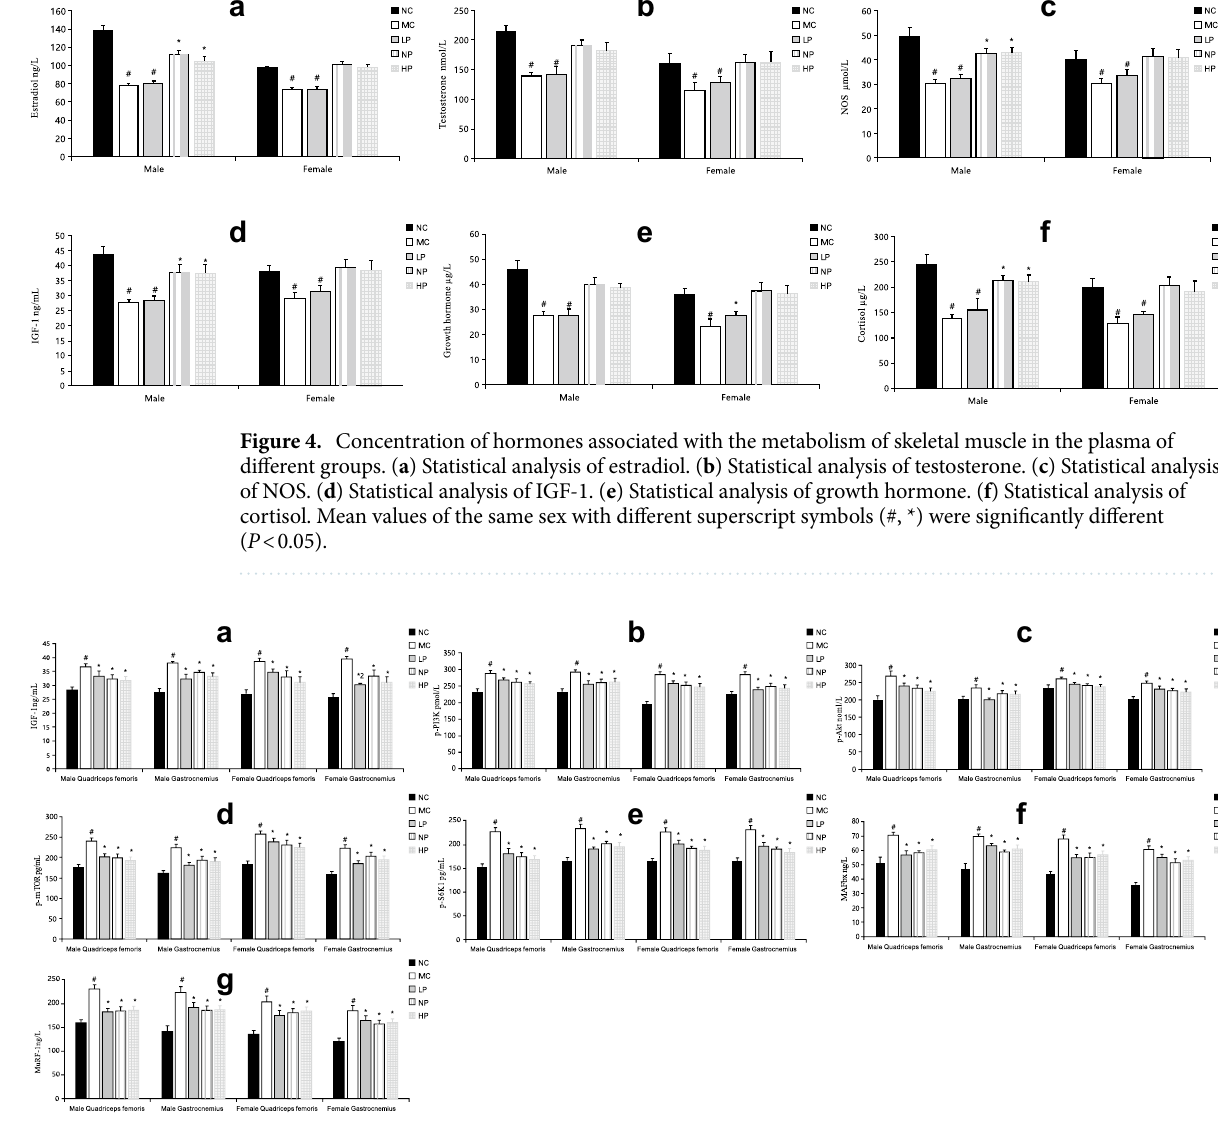
Figure 5. Concentration of factors in the pathways associated with the protein metabolism in the skeletal muscles of different groups. ( a ) Statistical analysis of IGF-1. ( b ) Statistical analysis of p-PI3K. ( c ) Statistical analysis of p-Akt. ( d ) Statistical analysis of p-mTOR. ( e ) Statistical analysis of p-S6K1. ( f ) Statistical analysis of MAFbx. ( g ) Statistical analysis of MuRF-1. Mean values of the same muscle type and the same sex with different superscript symbols (#, *) were significantly different ( P <